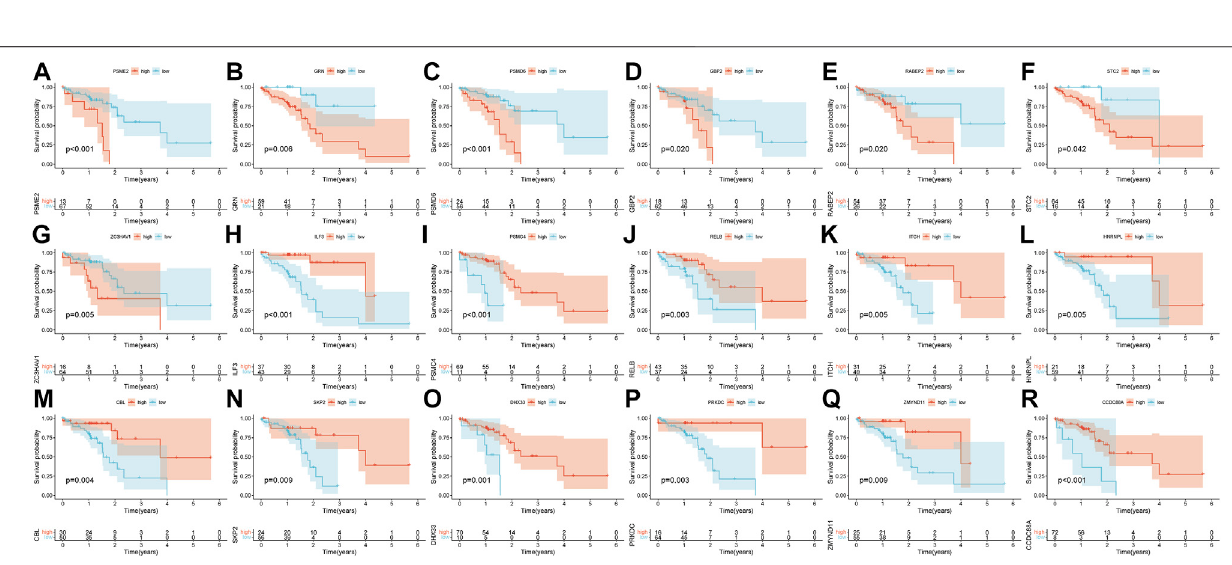
FIGURE 4 | Kaplan-Meier survival curves of the 18 prognostic genes (A – R)